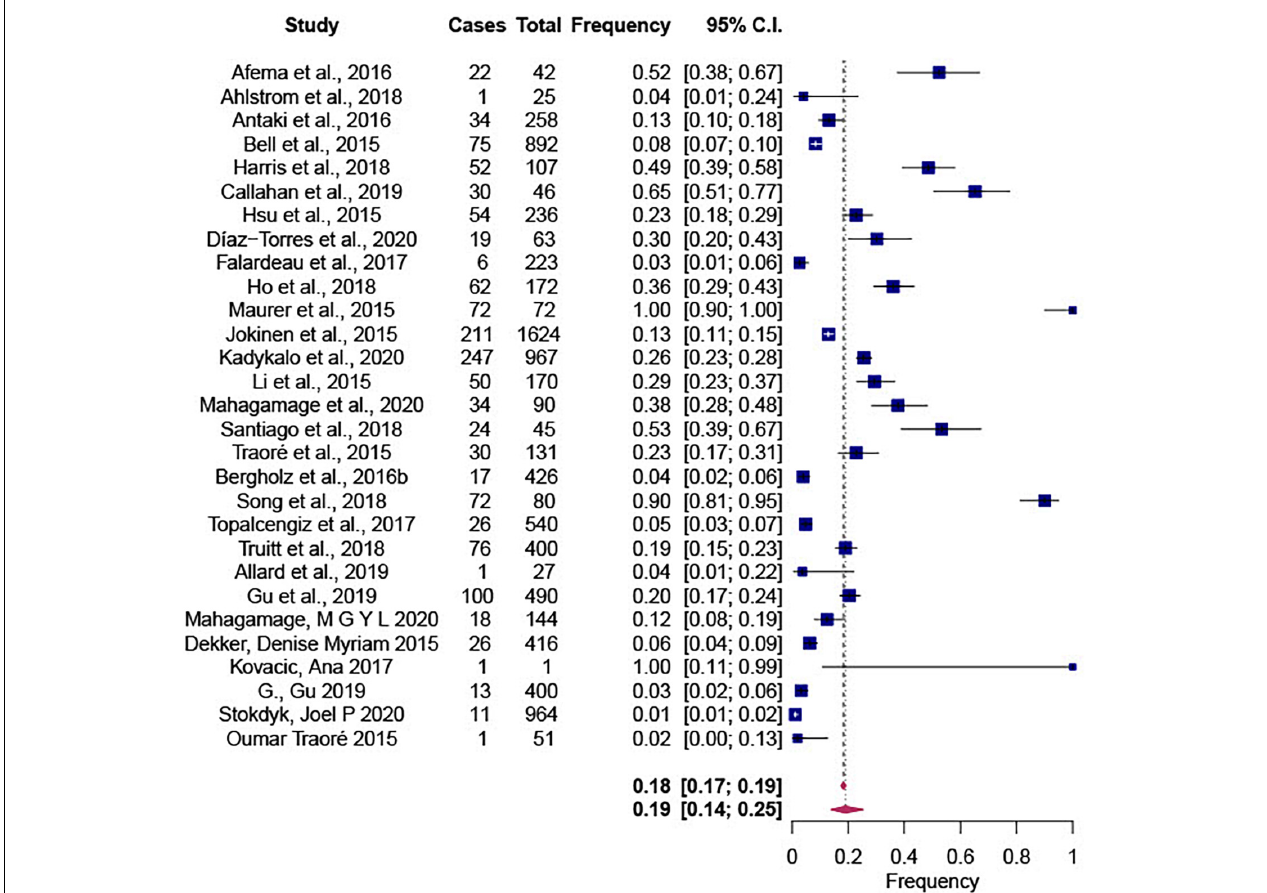
FIGURE 3 | Forest plot showing the summary effect size of proportions of Salmonella frequencies in non-recycled water sources using 26 selected articles and 29 observations. This summary effect size was obtained in R 4.11 (package metafor) by fitting a random-effects model using the restricted maximum-likelihood estimator (RMLE). Heterogeneity parameters and statistics are indicated in the model.